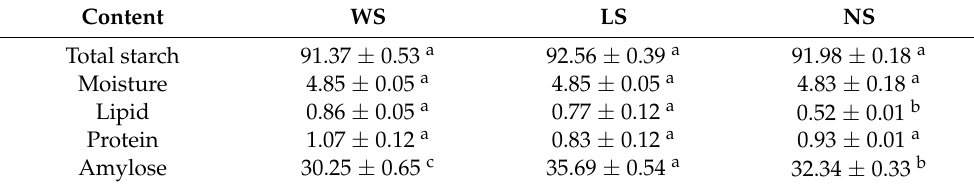
Table 1. Physicochemical compositions of starch samples extracted by different methods.